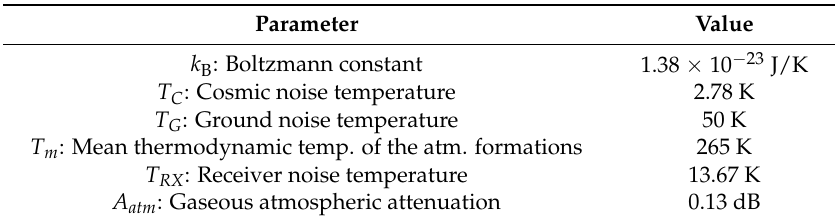
Table 3. Parameters for the evaluation of E s / N 0